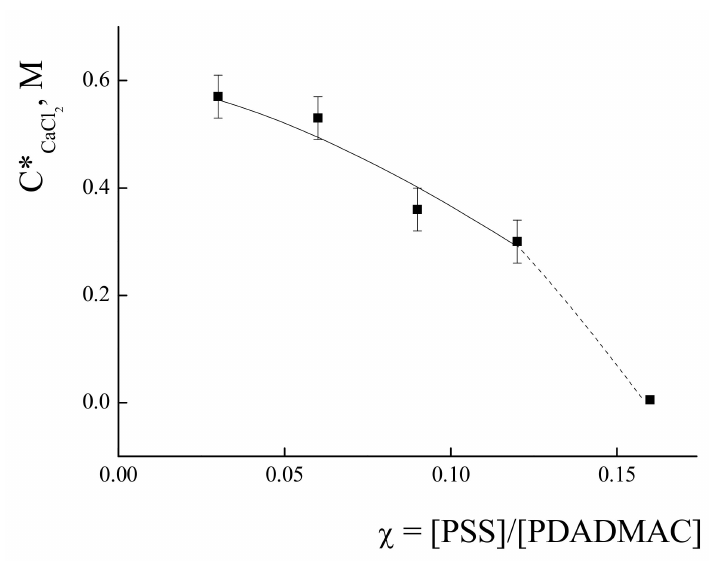
Figure 4. Values of critical salt concentration of CaCl 2 corresponding to the onset of phase separations in IPECs solutions prepared by mixing PSS with solutions of PDADMAC versus IPEC composition χ . C PDADMAC = 4 × 10 − 4 base-mol/L, pH